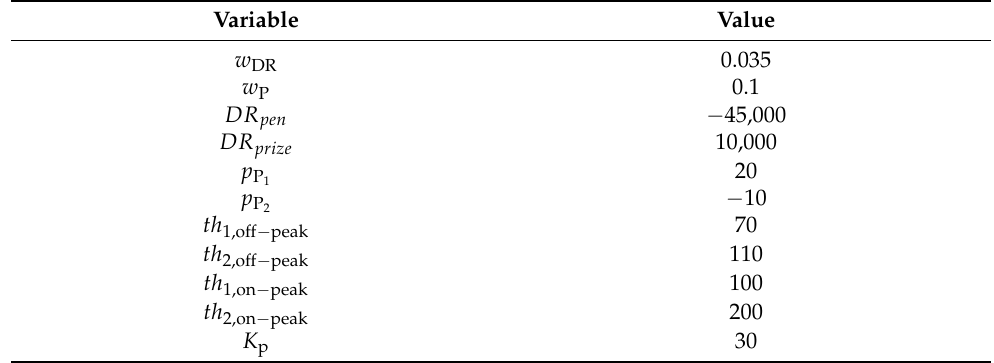
Table 3. Values assumed for DRL reward function features.